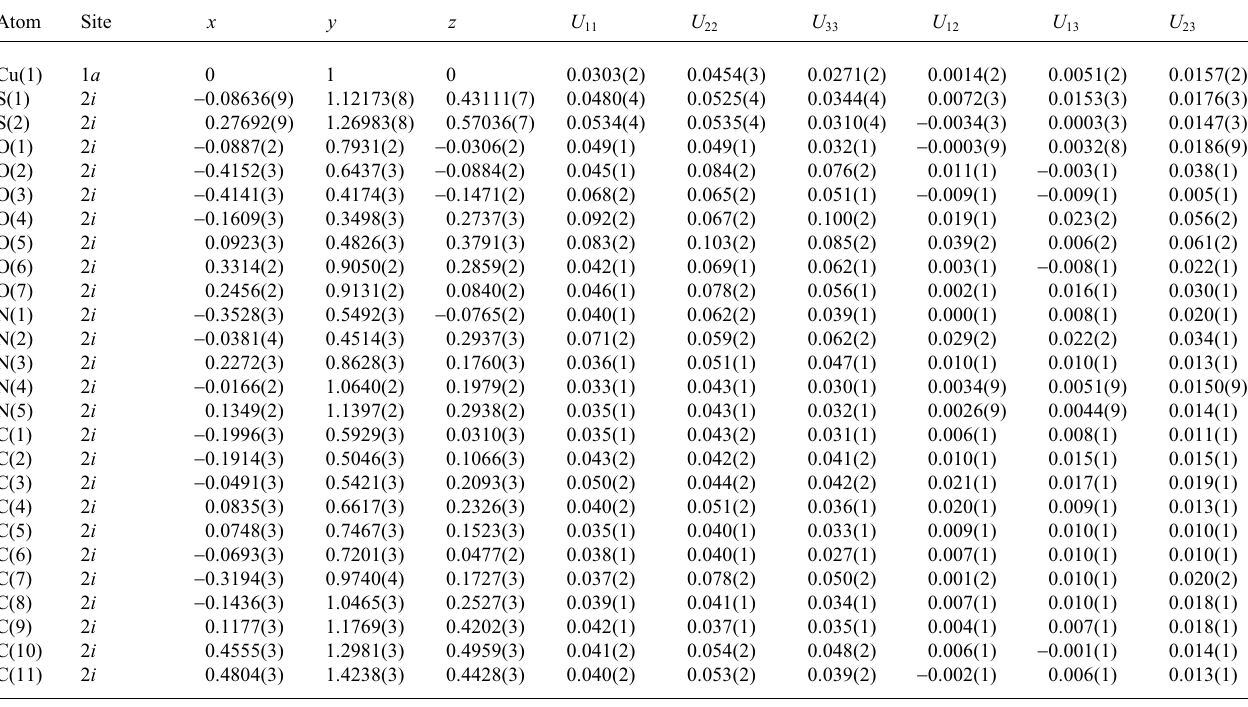
Table 3. Atomic coordinates and displacement parameters (in Å 2